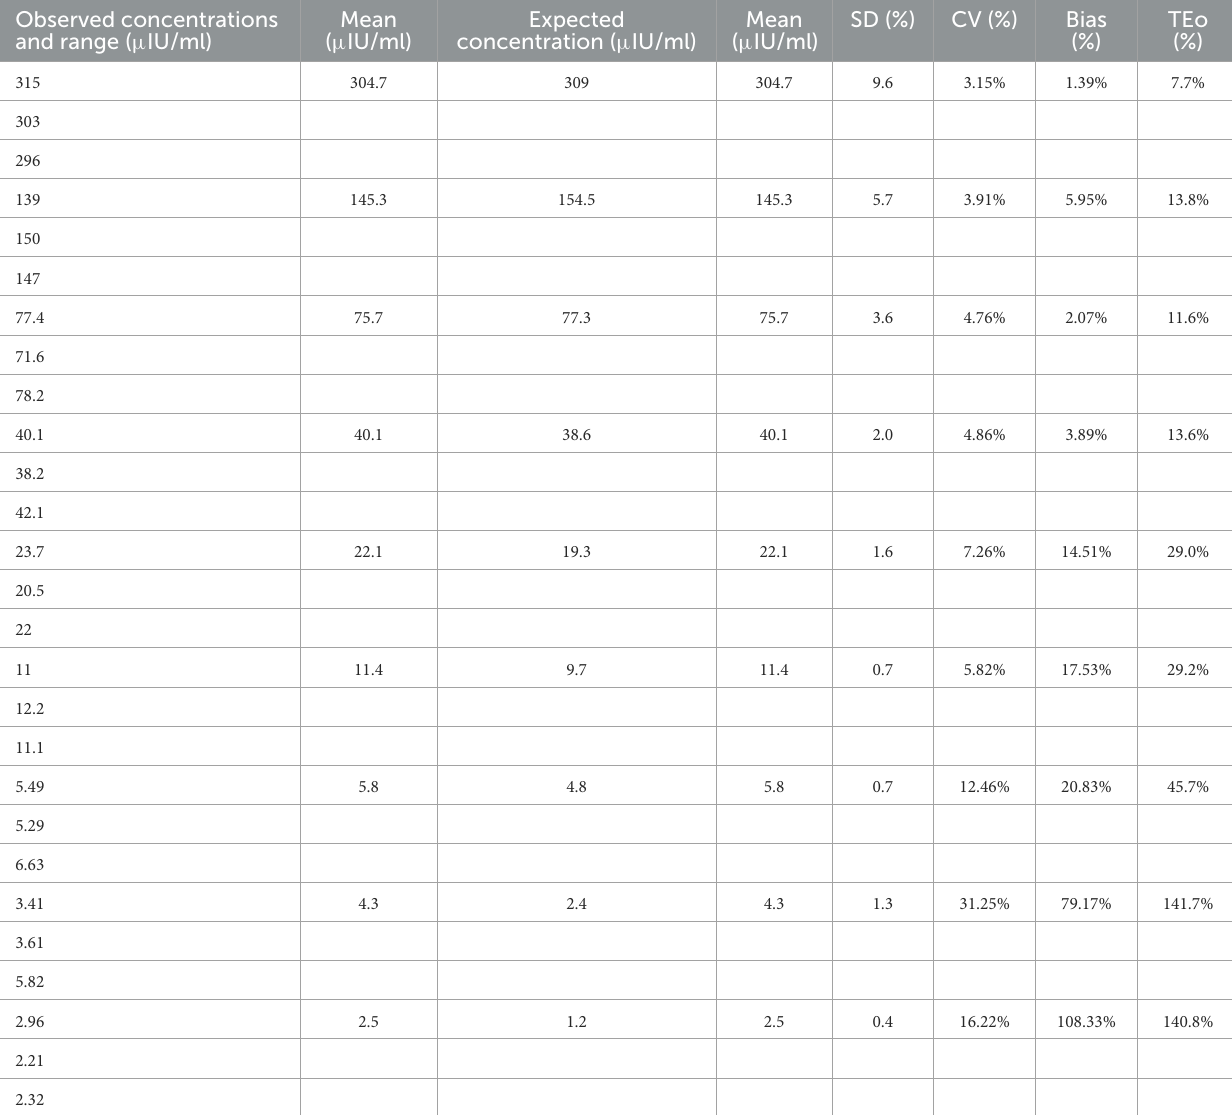
TABLE 4 Insulin values ( µ IU/ml) in triplicate at each level showing individual values, mean values, range, standard deviation (SD), CV% (coefficient of variation percent), percent bias (bias%), and total observed error (TEo%). Observed concentrations and range ( µ